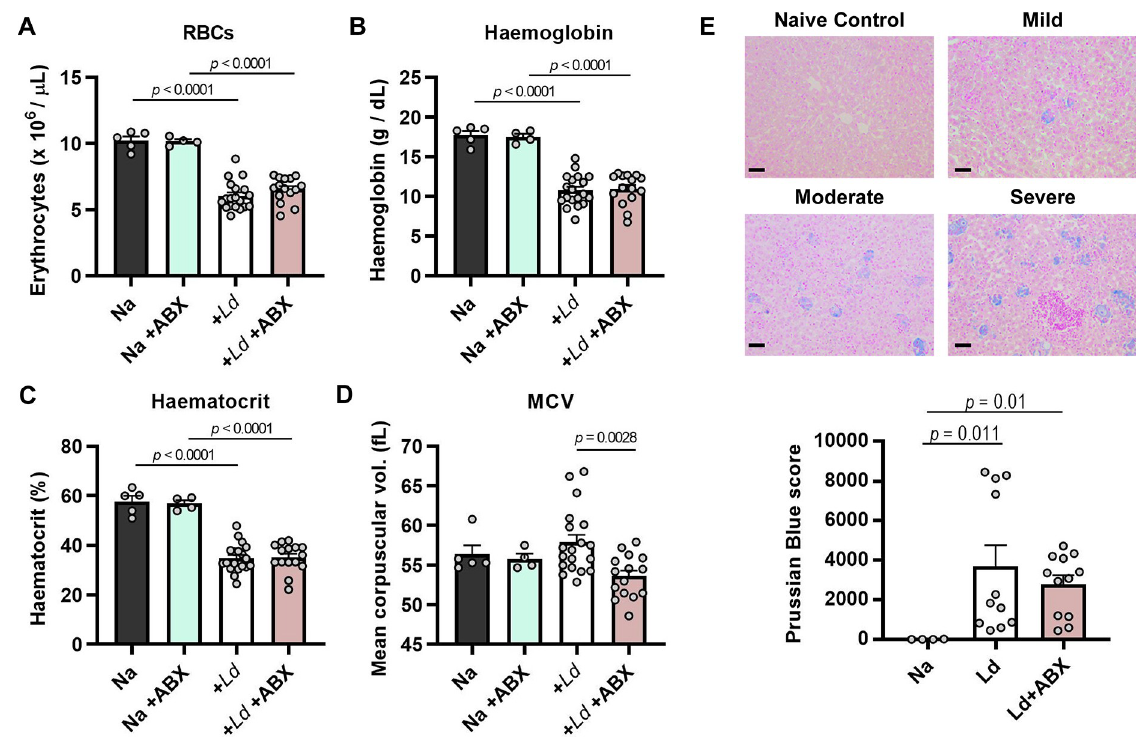
Fig 6. Anaemia and iron sequestration in dysbiotic hamsters infected with L . donovani . Hamsters were maintained on drinking water with or without antibiotic cocktail (ABX) and infected with L . donovani (n = 15–19) and compared with na ï ve (Na) controls (n = 4–5). The erythrocytic compartment was analysed with respect to total red cell count (A), haemoglobin levels (B), haematocrit (C) and mean corpuscular volume (D). (E) Representative images and quantification of ferric iron content in liver sections stained with Prussian blue (n = 4–12), magnification 200X, scale bars 50 μ m. All data are from 12 weeks post-infection, with mean +SEM and individual hamster data points shown. Groups were compared by one way ANOVA (A-D) or Kruskal-Wallis test (E) and differences at p < 0.05 are